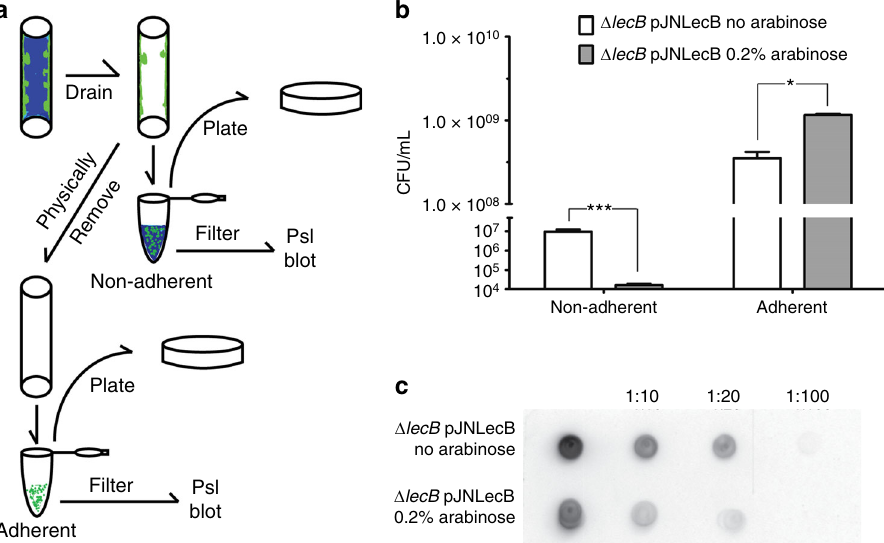
Fig. 7 LecB retains cells and matrix material in adherent biomass. a Schematics of procedures performed in the samples from the tube bio fi lm experiment. Tubes are represented containing biomass (green) and media (blue). b Quanti fi cation of non-adherent and adherent Δ lecB pJNLecB cells without or with 0.2% arabinose. Absence of LecB results in increased number of non-adherent cells compared with when LecB is present. Expression of lecB increases the number of cells adhered to the tube surface compared with when LecB is not present. *** p < 0.0001, * p < 0.005 t -test, n > 3. c Dot blot of non-adherent fractions derived from Δ lecB pJNLecB without or with 0.2% arabinose 6-day-old tube bio fi lms. Immunodetection was performed using anti-Psl antibodies. Expression of lecB leads to decreased levels of released Psl when compared with the uninduced